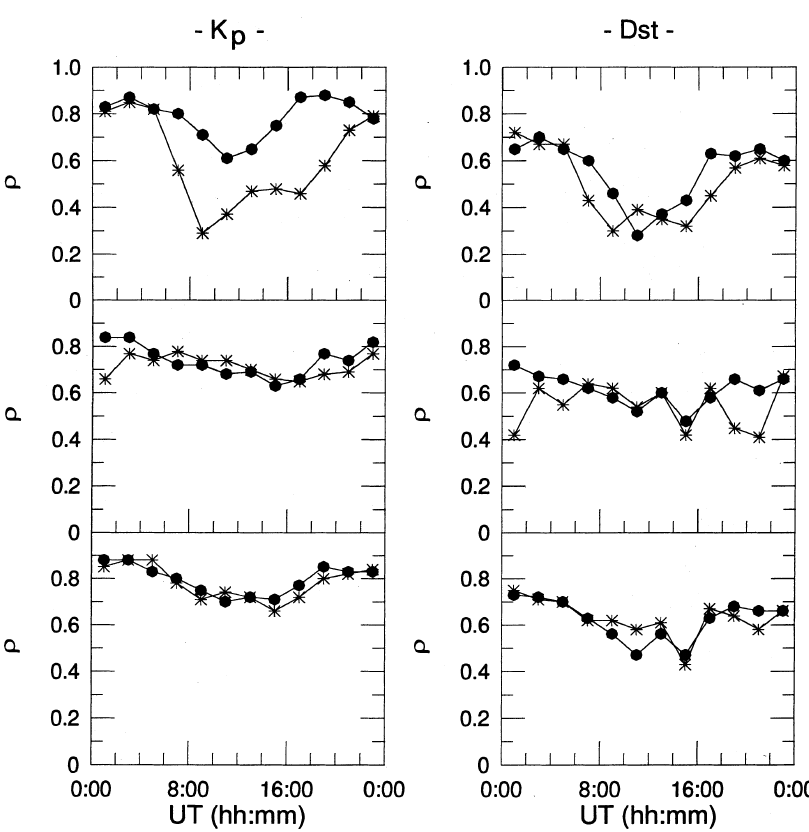
Fig. 1. Correlations of auroral indices and new indices with Kp and Dst at di(cid:128)erent UT times. The top panels show correlation coef- ficients for AU ( d ) and AUS-80 (*), the middle panels for AL ( d ) and ALS-80 (*), the bottom panels for AE ( d ) and AES-80 (*); each point is shown at the centre of the 2 h interval to which